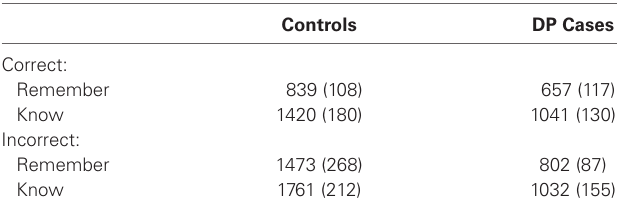
Table 4 | Mean response times (RTs) of correct and incorrect responses in ms (standard errors) .